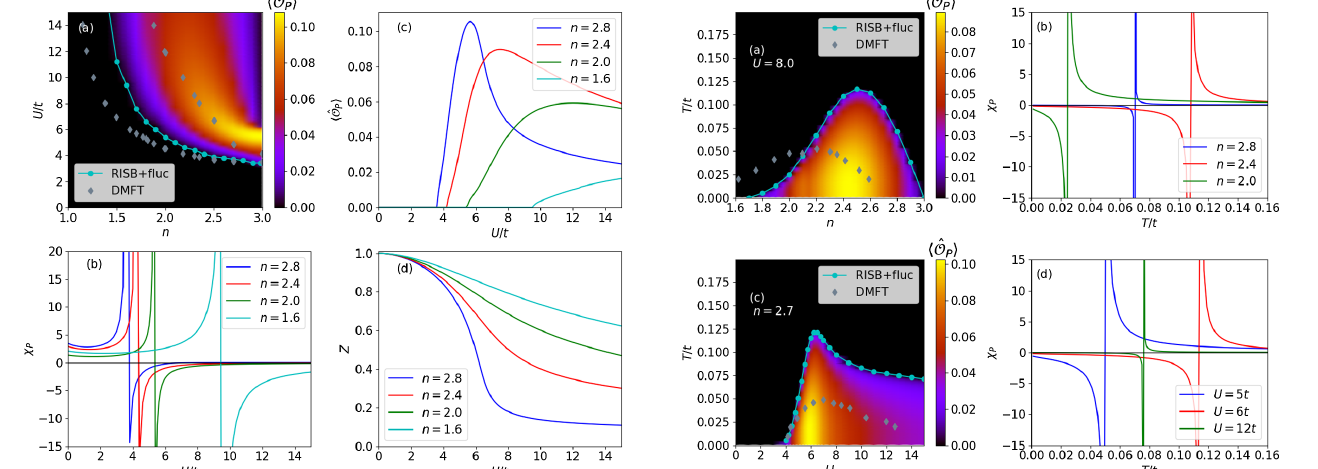
FIG. 4. (a) Density plot of the s -wave spin-triplet supercon- ˆ O ducting order parameter h as a function of electron filling n P i and Coulomb interaction U with J ¼ U= 4 at T ¼ 0 . 0005 t . The cyan line is the phase boundary determined from the instability in the pairing susceptibility χ . (b) Uniform pairing susceptibility P χ for n ¼ 2 . 8 , 2.4, 2.0, 1.6. (c) Spin-triplet superconducting P ˆ O for n ¼ 2 . 8 , 2.4, 2.0, 1.6. (d) Quasiparticle order parameters h P i weight Z for n ¼ 2 . 8 , 2.4, 2.0, 1.6.